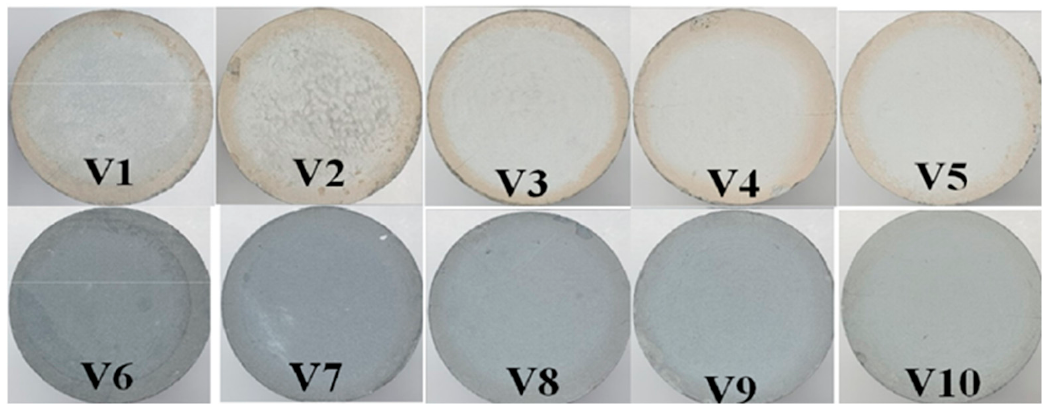
Figure 3. Surfaces of cured specimens for algorithm verification.